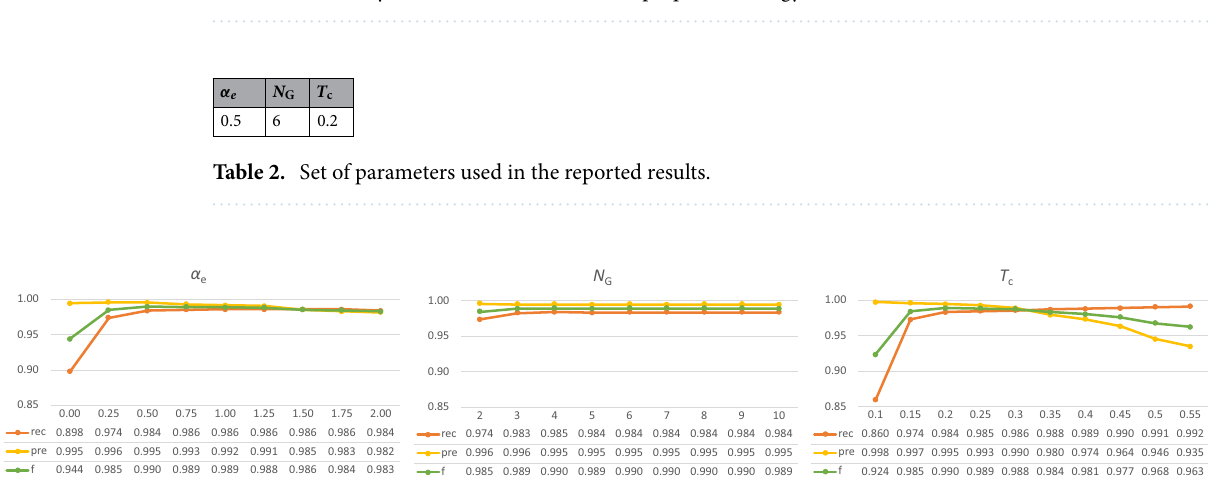
Table 1. Summary of results obtained with the proposed strategy.